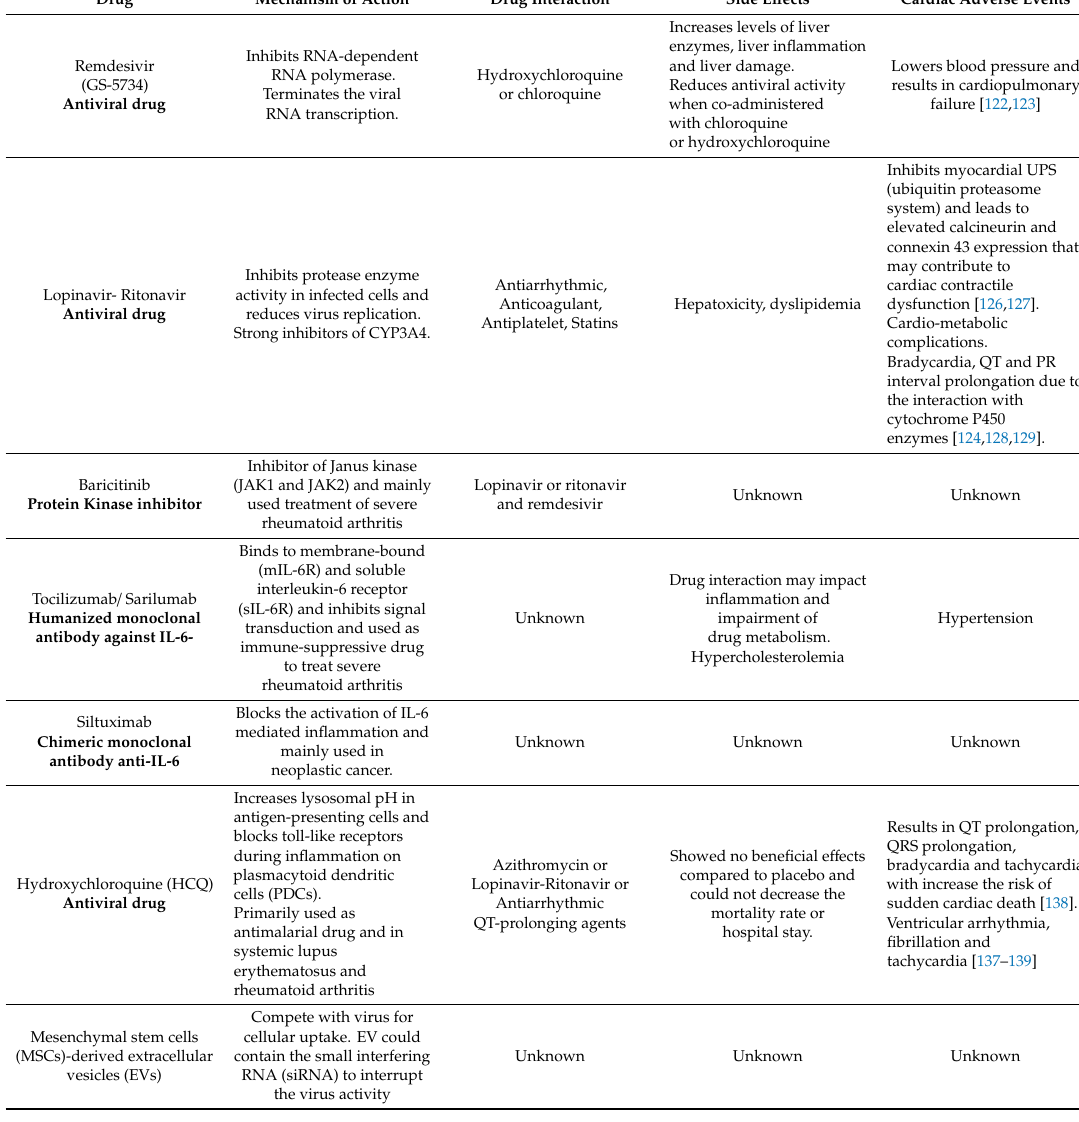
Table 1. Mechanisms of action and adverse cardiac e ff ects of drug treatments for COVID-19. Drug Mechanism of Action Drug Interaction Side E ff ects Cardiac Adverse Events Remdesivir